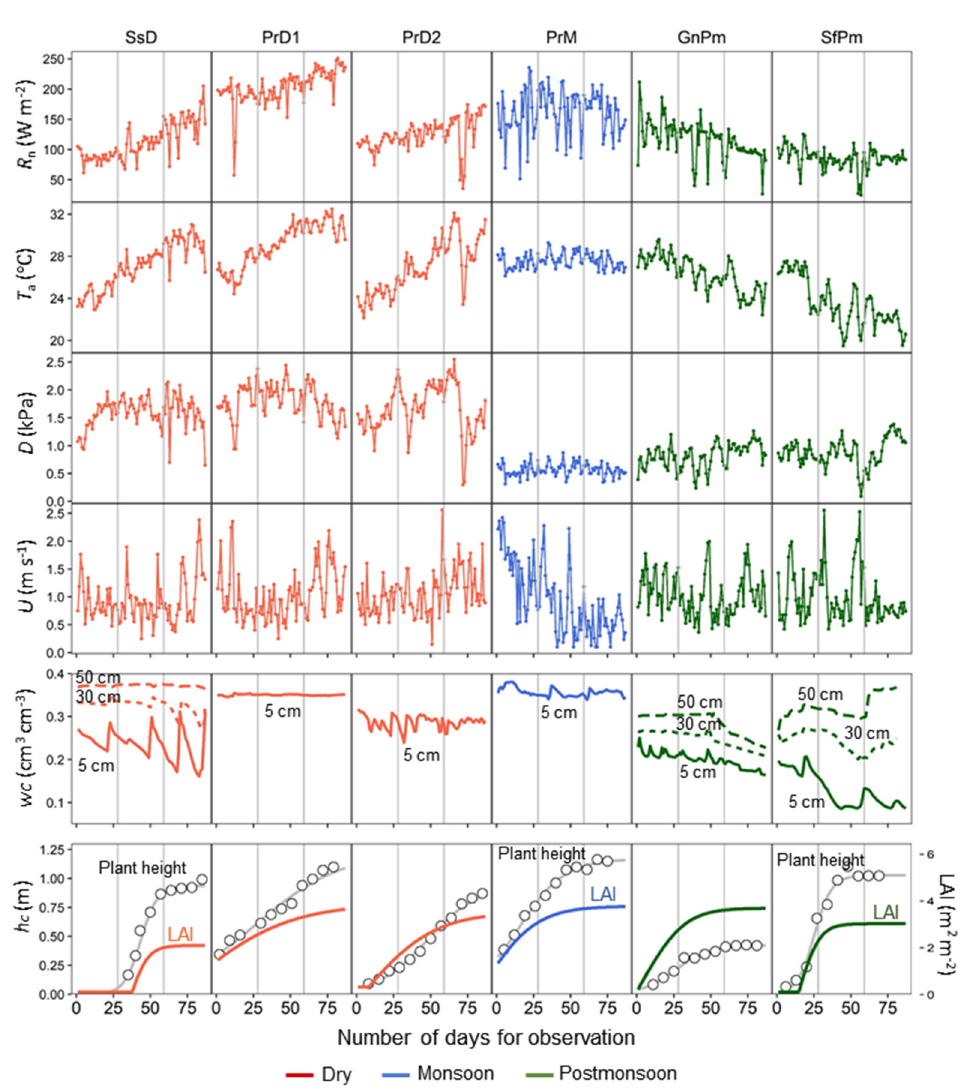
Figure 2. Variations in daily net radiation ( R n ), air temperature ( T a ), air water vapor pressure deficit ( D ), wind speed ( U ), soil moisture content ( wc ), and plant height ( h c ) with estimated leaf area index (LAI) in different observation periods at three fields in the dry season, a different field in the monsoon season, and a third set of two fields in the post-monsoon season. The three calibration periods for HB are indicated by vertical lines.